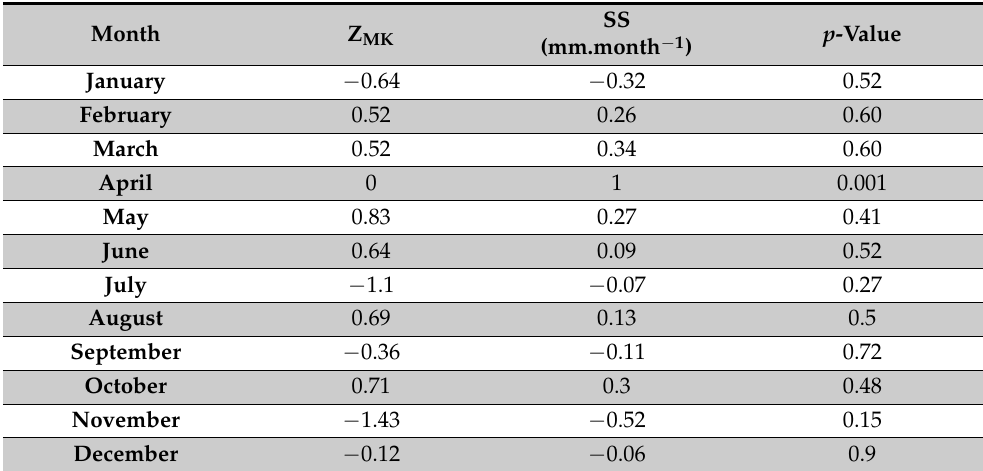
Table 5. Result of the Mann-Kendall test for monthly rainfall between 1981 and 2020 with the Z MK , Sen’s slope (SS) and p -value.